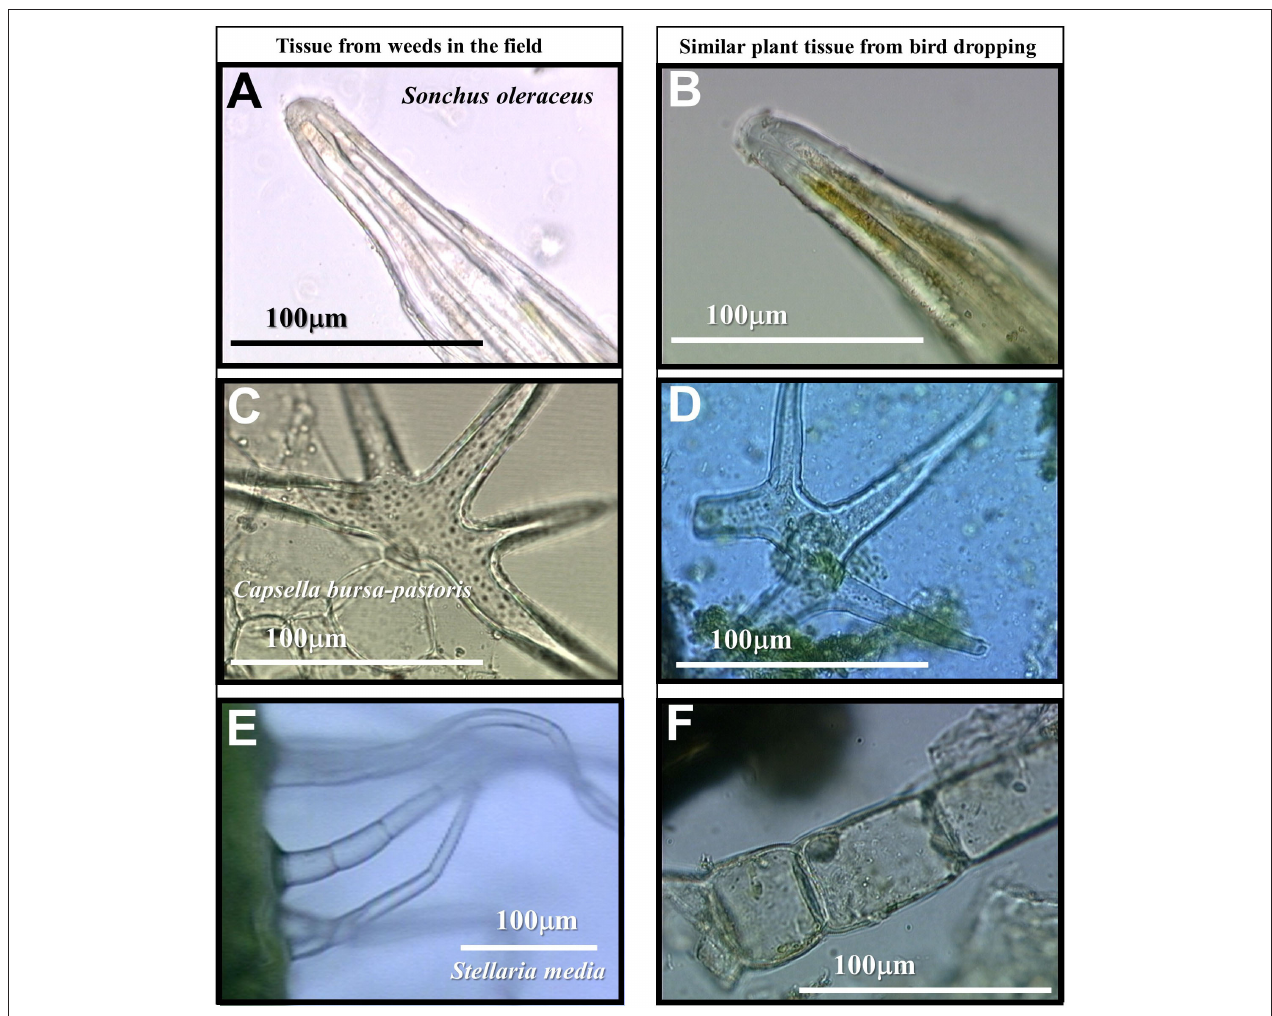
FIGURE 6 | Tissue with trichomes of three weed species in the cover crops. All species had signs of bird folivory. The photographs in the left column (A,C,E) were collected from intact plants while those in the right column (B,D,F) were from bird droppings under the cover crops and had similar morphological characteristics to the weed samples in the left column. Note that the scale is the same for all photographs except for (E) . Photograph (A) is a leaf edge trichome, (C) is a stellate (star shaped) leaf trichome, and (E) shows multicellular trichomes on the peduncle of immature